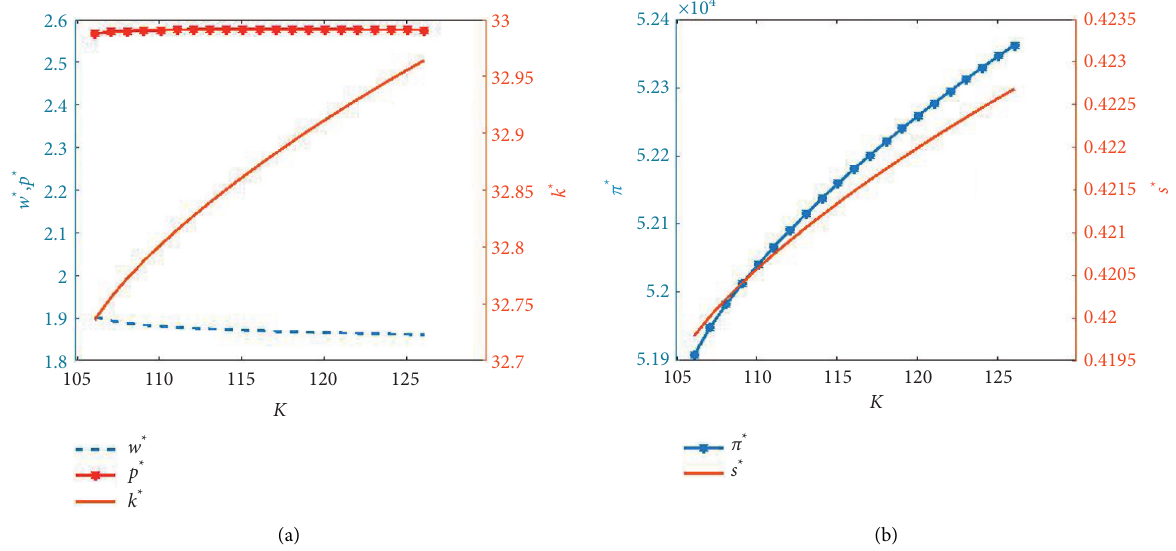
Figure 5: Sensitivity analysis of endogenous variables in terms of K . (a) p ∗ , w ∗ , and k ∗ . (b) s ∗